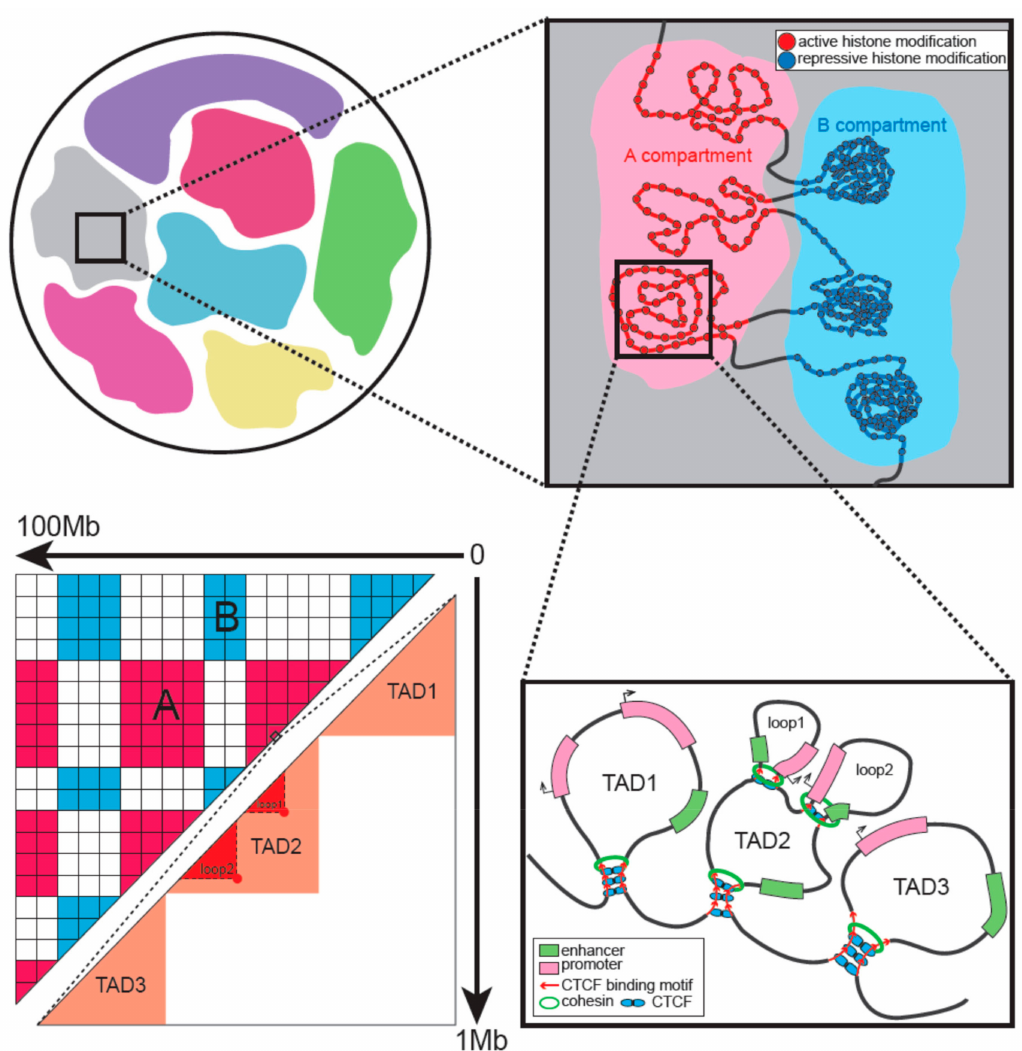
Figure 1. Hierarchical organization of interphase chromatin. Chromosomes occupy discrete space in the nucleus called chromosome territory. A and B compartments are characterized by active and repressive histone modifications, respectively. Topologically associating domains (TADs) and loops are formed by loop extrusion with the architectural proteins located in boundaries. The corresponding Hi-C heatmap is also illustrated. It shows the di ff erent scales of compartments and